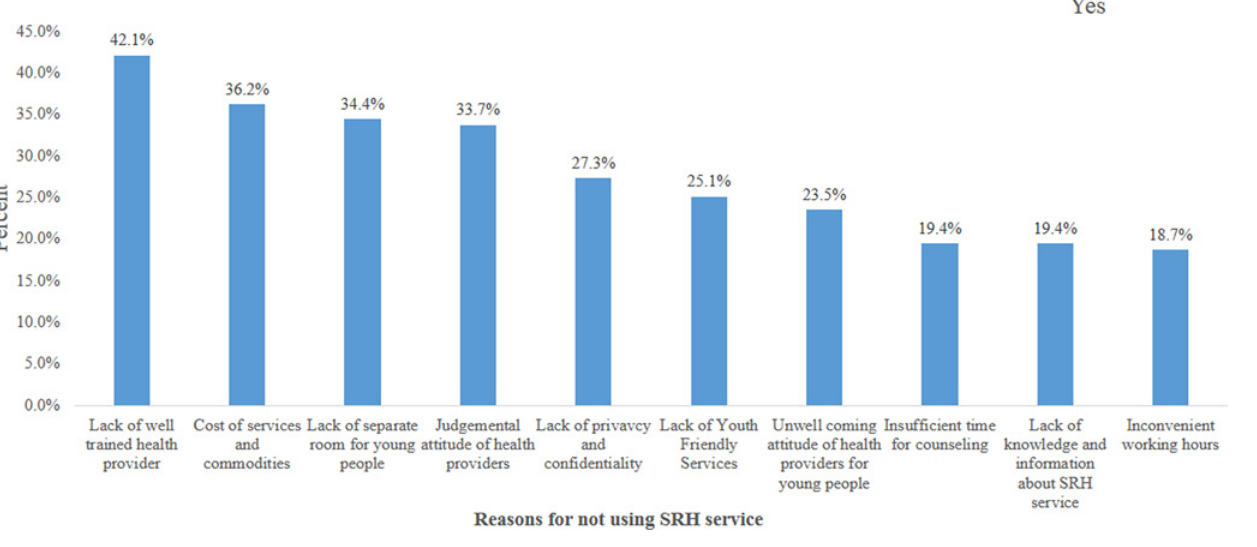
Fig 2. Reasons of young people for not utilizing SRH services in Northwest Ethiopia, 2015 (n = 439).